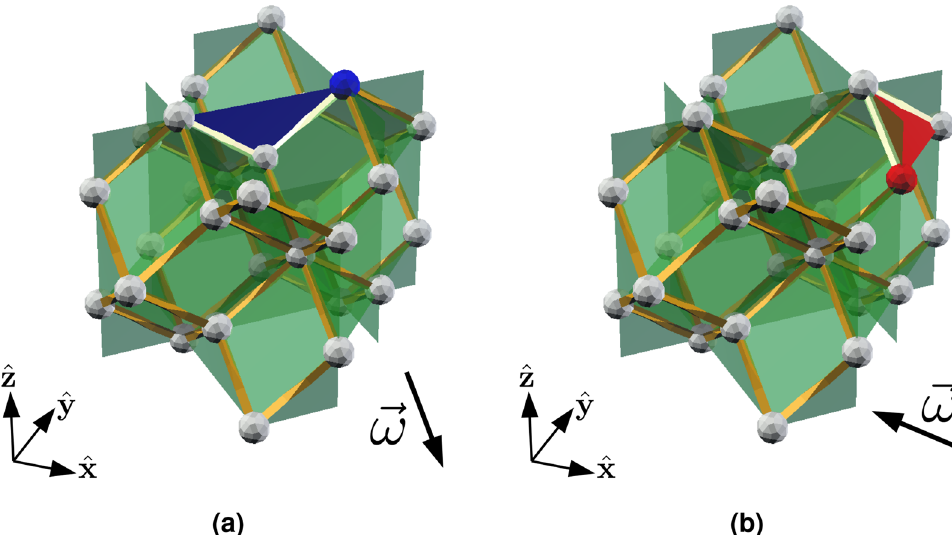
Figure 6. Vertices on the rough boundaries that do not satisfy the trailing vertex condition. In ( a ), we highlight such a vertex, v , in blue on the top rough boundary. Consider the highlighted qubit (blue face) and its syndrome (light yellow edges). For the sweep directions � ω = ( 1, − 1, − 1 ) and � ω ′ = ( − 1, 1, − 1 ) , v does not satisfy the trailing vertex condition because the blue face is not in ↑ ( v ) . In ( b ), we highlight a vertex in red on the right rough boundary that does not satisfy the trailing vertex condition for the same reason as ( a ), where the problematic sweep direction is � ω = ( − 1, − 1, 1 ) .